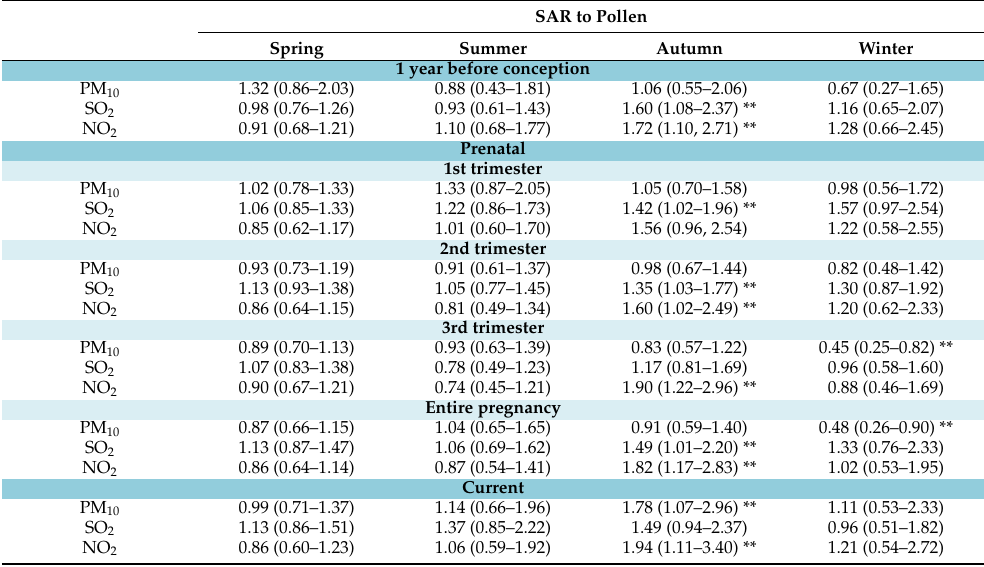
Table 3. Odds ratio (95% CI) of childhood seasonal SAR to pollen for exposure to outdoor air pollution during 1 year before conception, prenatal, and current periods ( n = 2598).